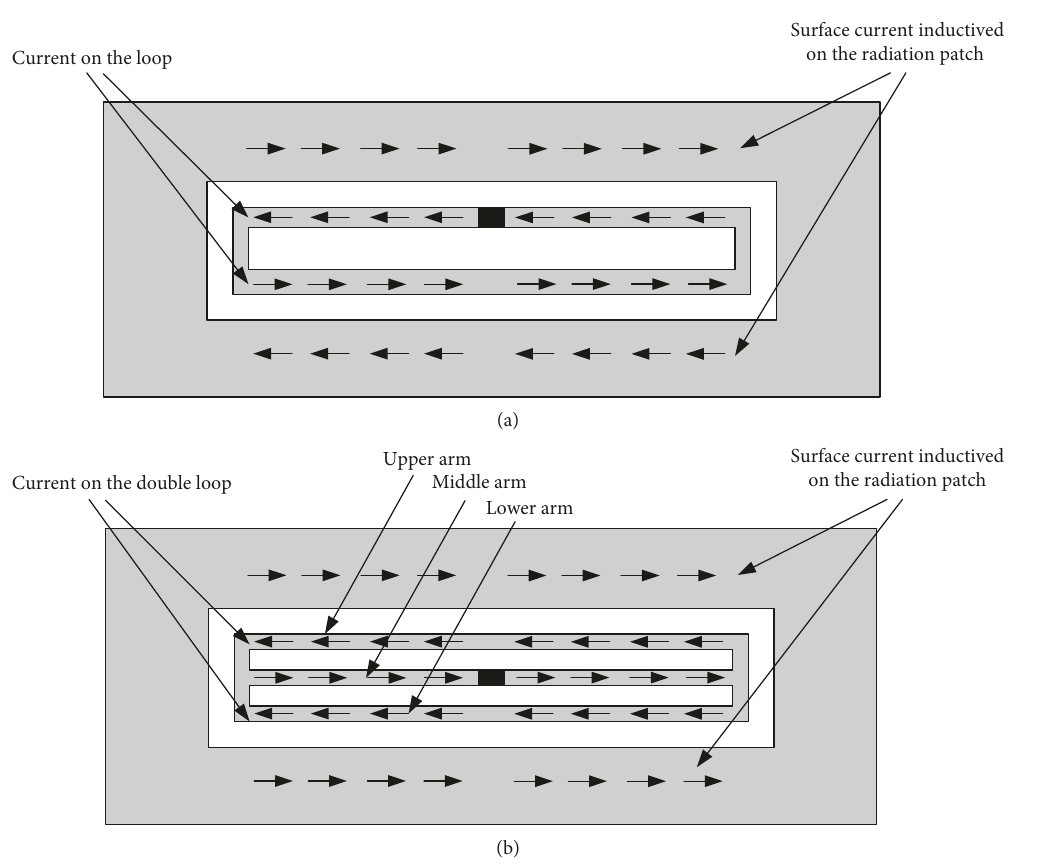
Figure 2: The surface currents of the loop inductive feed planar antenna. (a) One loop inductive feed planar antenna; (b) Double loop inductive feed planar